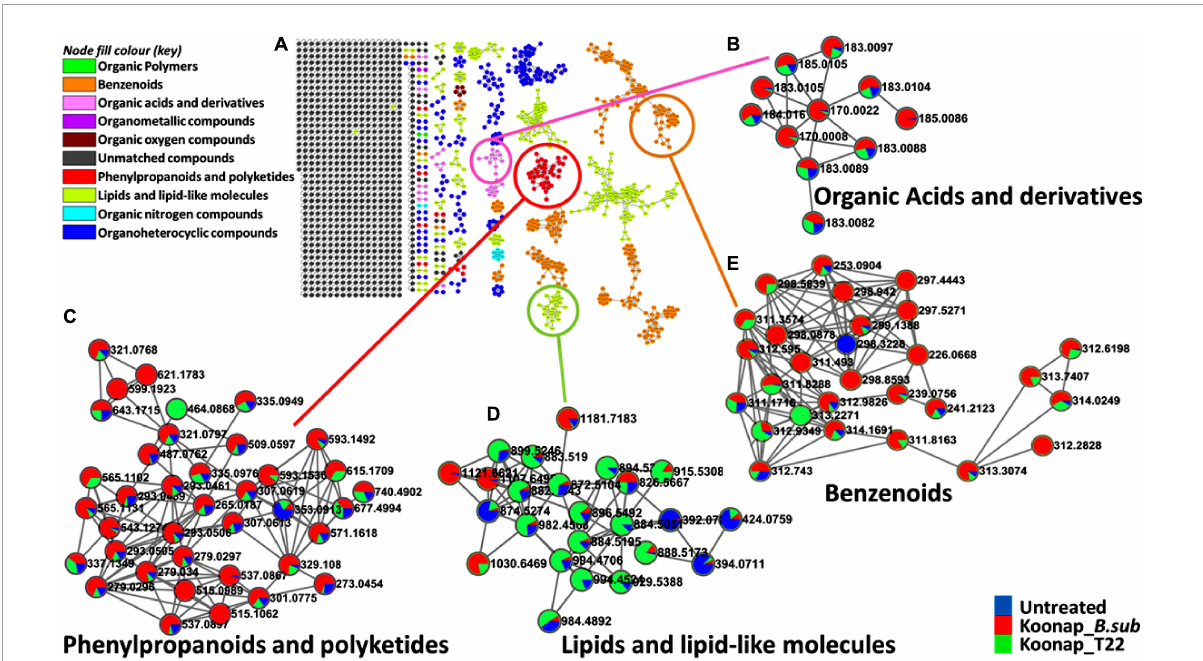
FIGURE3 A global metabolome view of the plant growth-promoting rhizobacteria (PGPR)-treated/untreated Koonap rhizosphere showing classes of detected metabolites driving the global differences between the treated and untreated rhizosphere soils. (A) Molecular network of MS/MS spectra generated with MolNetEnhancer (in GNPS) giving a metabolome coverage and classes of extracted metabolites from rhizosphere soil of plant growth-promoting rhizobacteria (PGPR)-treated and untreated Koonap cultivar. Each displayed node represents a metabolite, while each cluster of pooled nodes (colored) depicts a class of chemically related and putatively annotated metabolites matched to GNPS libraries and databases. Gray nodes represent unmatched spectral data. (B–E) Shows clusters of organic acids and derivatives, phenylpropanoids, and polyketides, lipids and lipid-like molecules and benzenoids respectively. Each node representing a spectral data shows the differential distributions and changes in the metabolites per treatment represented by the color shading. Blue shading represents the distribution of set class of metabolites (e.g., benzenoids) in untreated samples compared to Koonap_ B. sub (red) and Koonap_ P. alvei T22